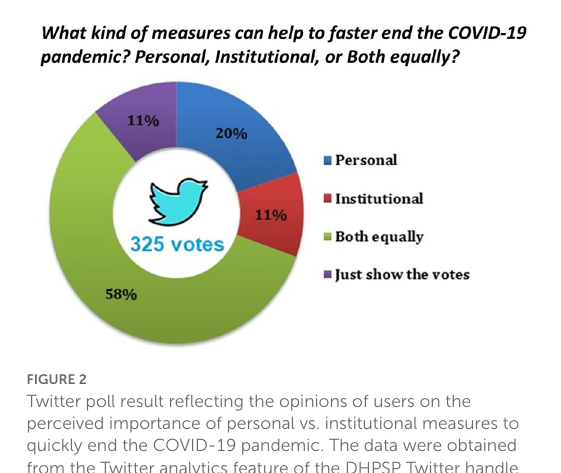
FIGURE2 Twitter poll result reflecting the opinions of users on the perceived importance of personal vs. institutional measures to quickly end the COVID-19 pandemic. The data were obtained from the Twitter analytics feature of the DHPSP Twitter handle on February 12, 2022 (Chi-square test [compared the number of votes in each response option with an expected equal number of responses in each option; statistical significance indicates that the votes in four response options did not occur by chance]: χ 2 [3] = 201.5, P <